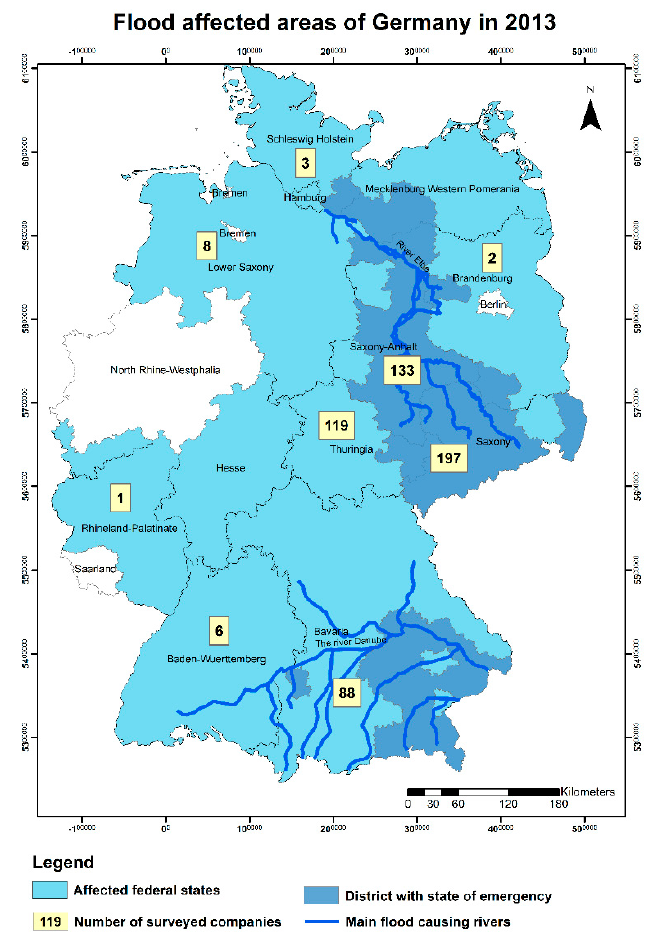
Figure 1. Affected federal states, as well as districts, declared states of emergency and the number of surveyed companies after the 2013 flood (own representation, following [4]).